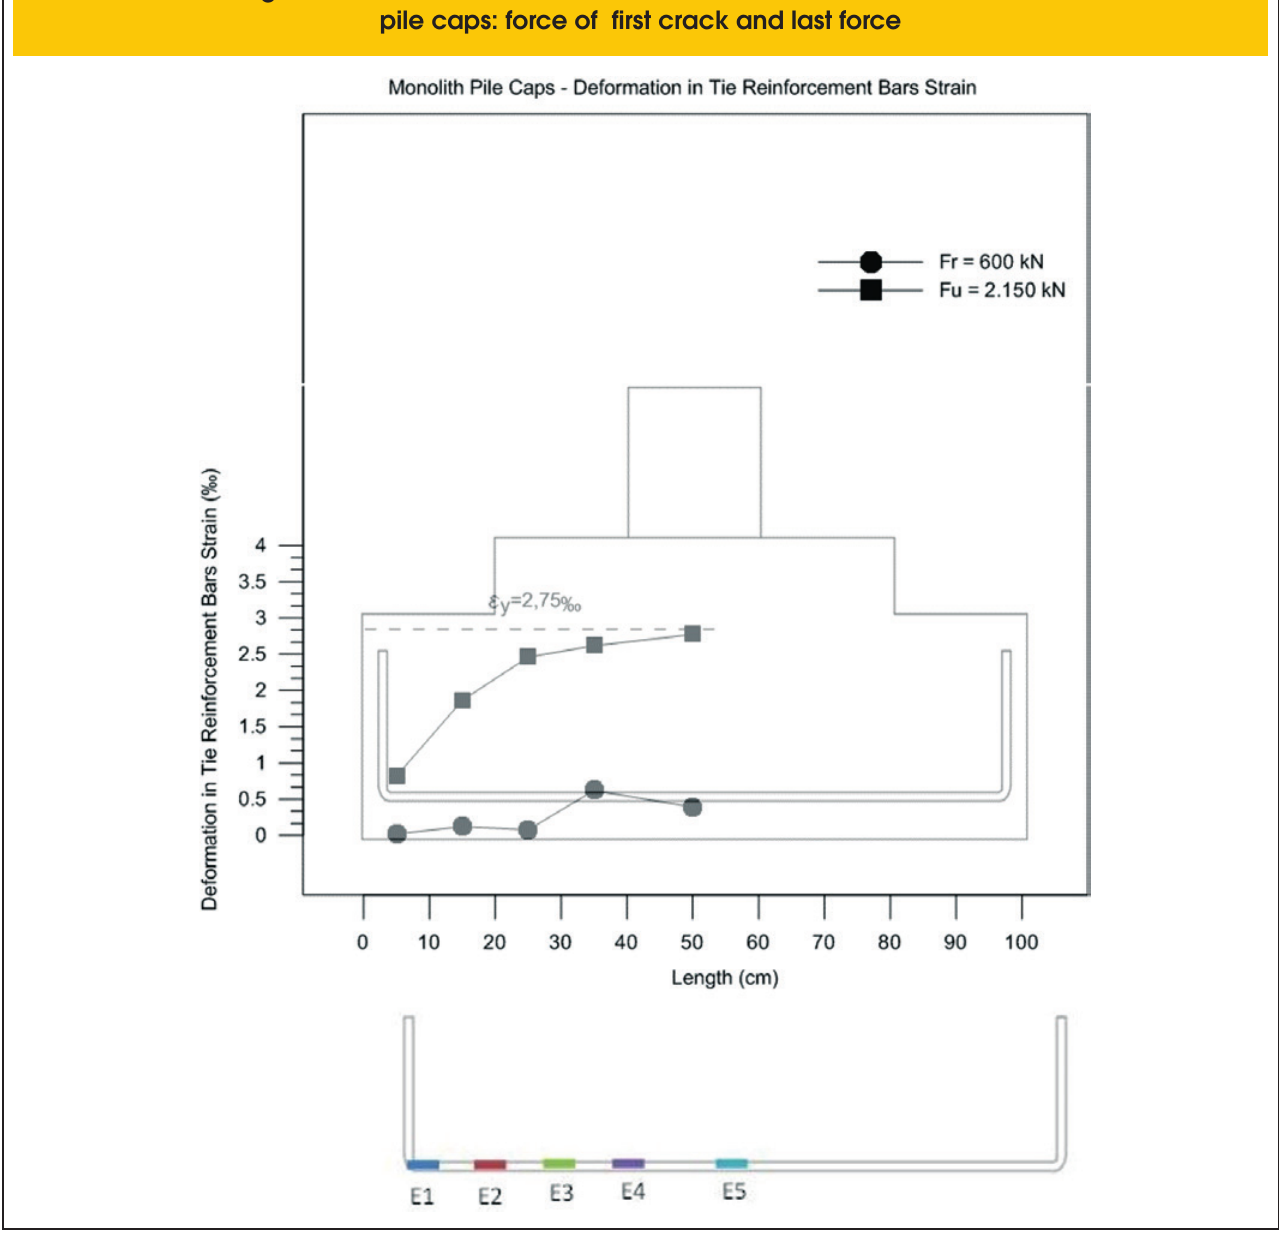
Figure 10 – Deformations in tie reinforcement bars strain – monolith pile caps: force of first crack and last